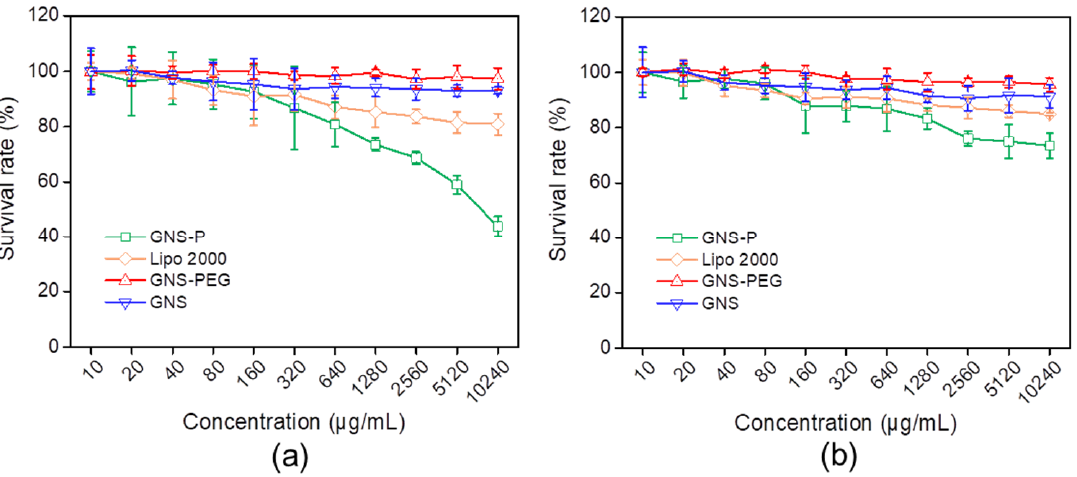
Figure 7. ( a ) Cytotoxicity of different concentrations of vectors on tumor cells Panc02. ( b ) Cytotoxicity of different concentrations of vectors on normal cells NIH3T3.